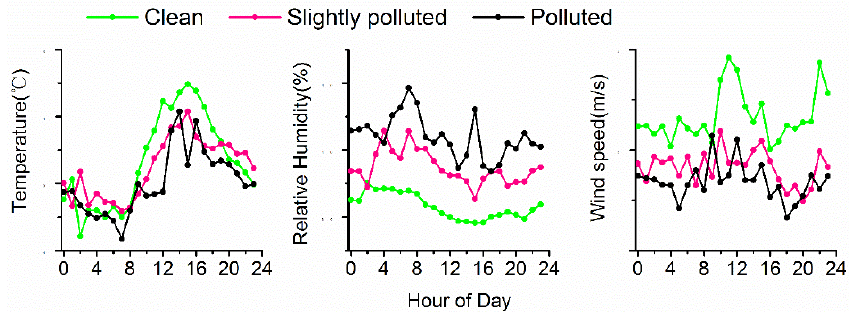
Figure 5. Diurnal variation of meteorological parameters for different pollution levels.